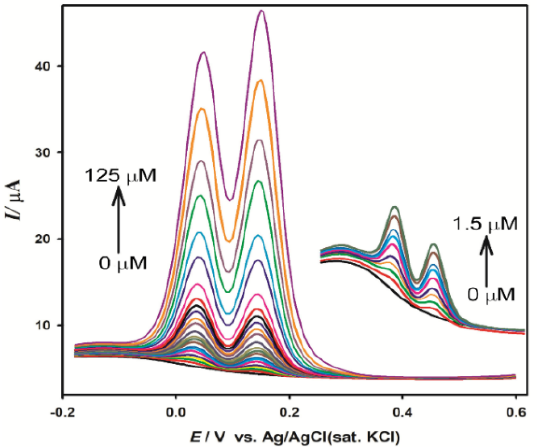
Figure 6. Differential pulse voltammograms of equimolar mixtures of hydroquinone and catechol at the over-oxidized polyrutin-based sensor in phosphate buffer pH 7.2. Reprinted from [53] with permission from Elsevier.